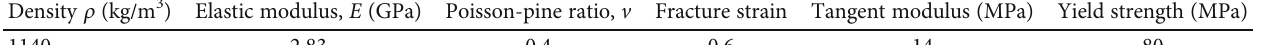
Table 3: Nylon material parameters.